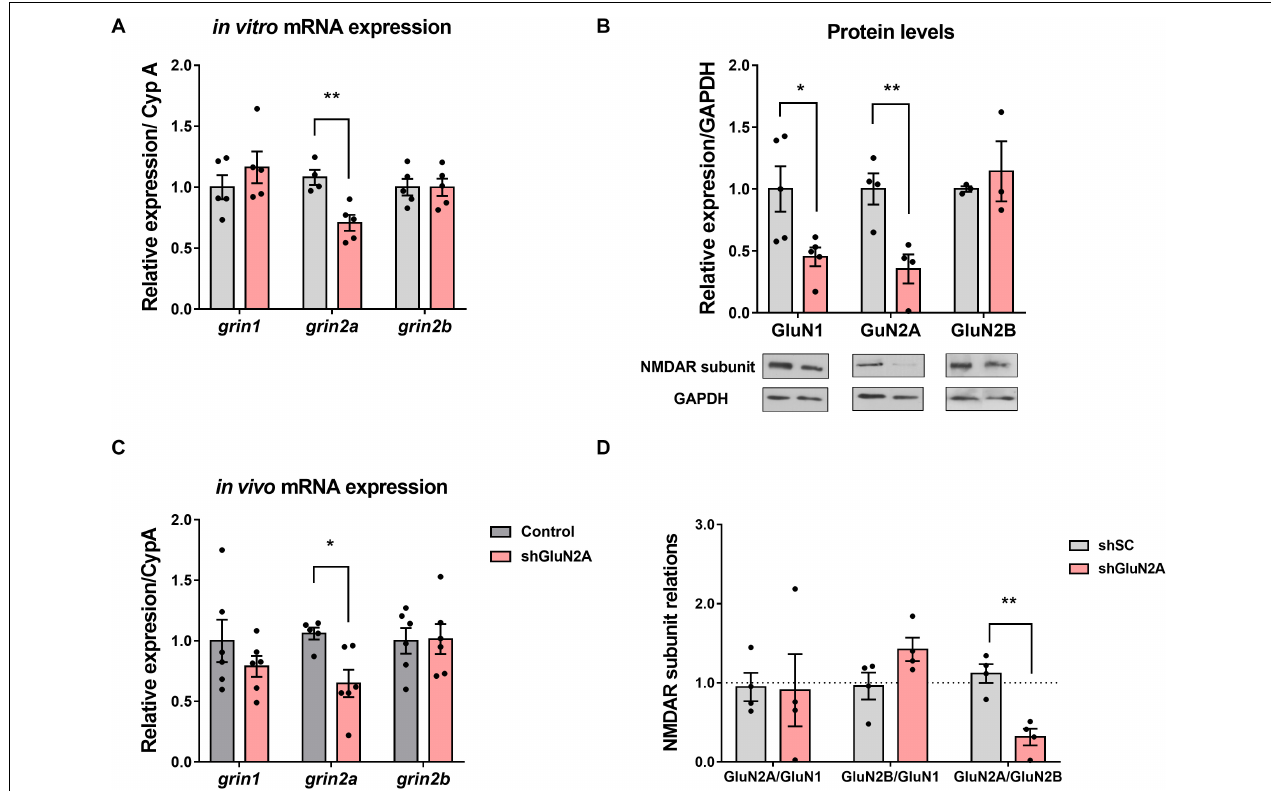
FIGURE 2 | NMDAR expression in the GluN2A-reduced expression in vitro model. (A) Primary hippocampal neuronal cultures infected with AAVe-shGluN2A showed a significant reduction in grin2a mRNA expression (** p < 0.01, unpaired t test). However, no significant differences were detected in grin1 ( p = 0.3467, unpaired t test) or in grin2b mRNA ( p = 0.9922, unpaired t test, n = 5 independent cultures). (B) NMDAR main subunit protein levels at 6 DPI. GluN2A and GluN1 levels were significantly decreased in shGluN2A-transduced cultures compared with the shsc-transduced ones (** p < 0.01, * p < 0.05, unpaired t test). GluN2B levels remained similar to controls ( p = 0.5875, unpaired t test, n = 5 independent cultures). (C) mRNA analysis of NMDAR subunit expression at the hippocampus of AAVe-injected rats at 20DPI. grin2a expression was significantly decreased in the hippocampi from GluN2A KD rats (* p < 0.05, unpaired t test, n = 6), whereas grin1 and grin2b levels ( p = 0.3057 and p = 0.9285, respectively, unpaired t test) were similar to control (shsc injected) animals. (D) Relative abundance of NMDAR subunits in the primary hippocampal neuronal cultures. There was an imbalance in the ratio between the regulatory subunits GluN2A and GluN2B in the shGluN2A-transduced cultures (** p < 0.01, unpaired t test, n = 4 independent cultures). On the other hand, GluN2A/GluN1 and GluN2B/GluN1 ratios remained similar to shsc-transduced cultures ( p = 0.9360 and p = 0.0853, respectively, unpaired t test, n = 4 independent cultures). In all cases, bars represent mean ±